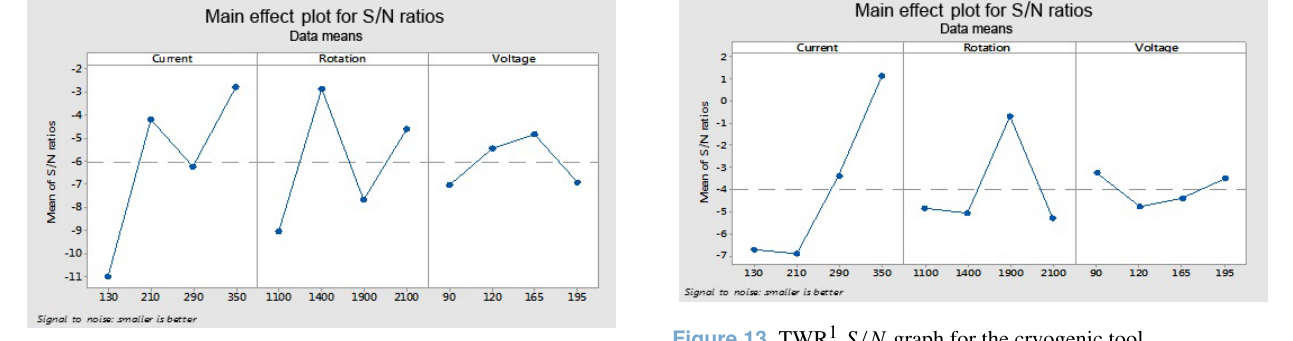
Figure 11. Ra S/N ratio graph for the non-cryogenic tool.